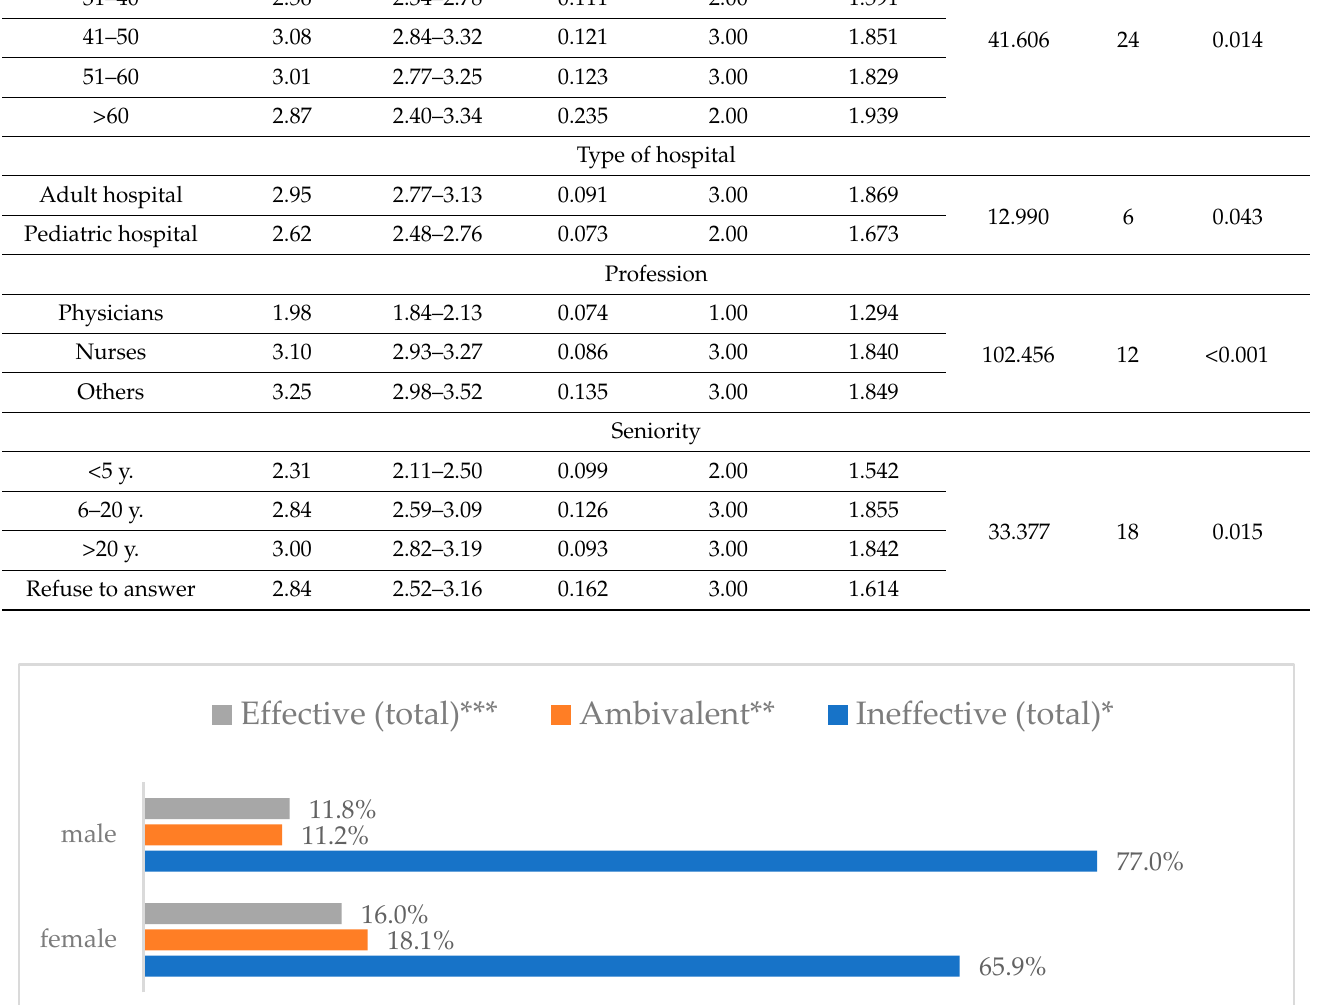
Figure 21. Eating garlic to prevent influenza virus infection by gender ( N = 905). *Sum of responses: completely ineffective, ineffective, rather ineffective; **Response: neither ineffective nor effective; ***Sum of responses: rather effective, effective, completely effective.